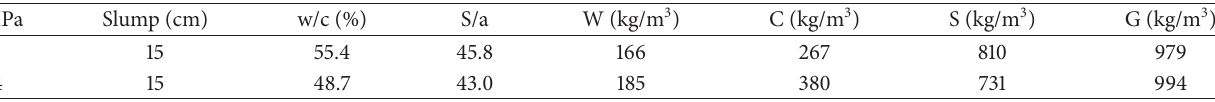
Table 2: Mixture proportions of concrete.